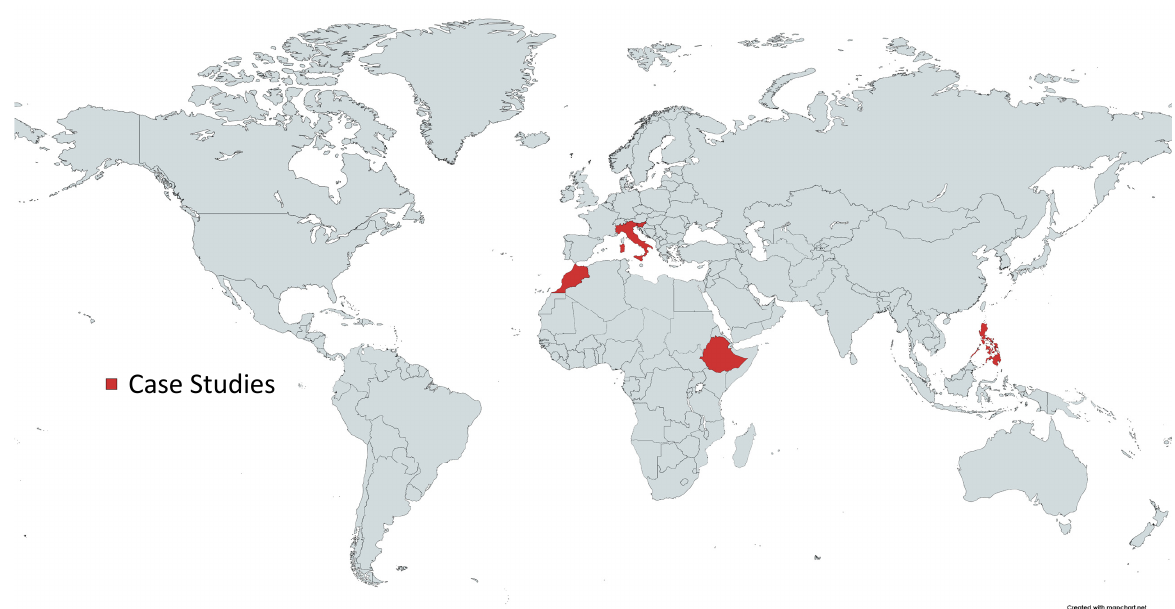
Figure 1. Case studies of the Special Issue were from few countries but well spatially sorted.